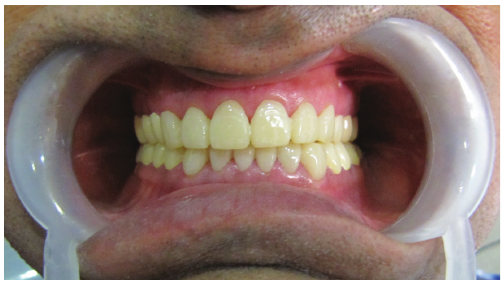
Figure 7: Provisional restorations were placed.